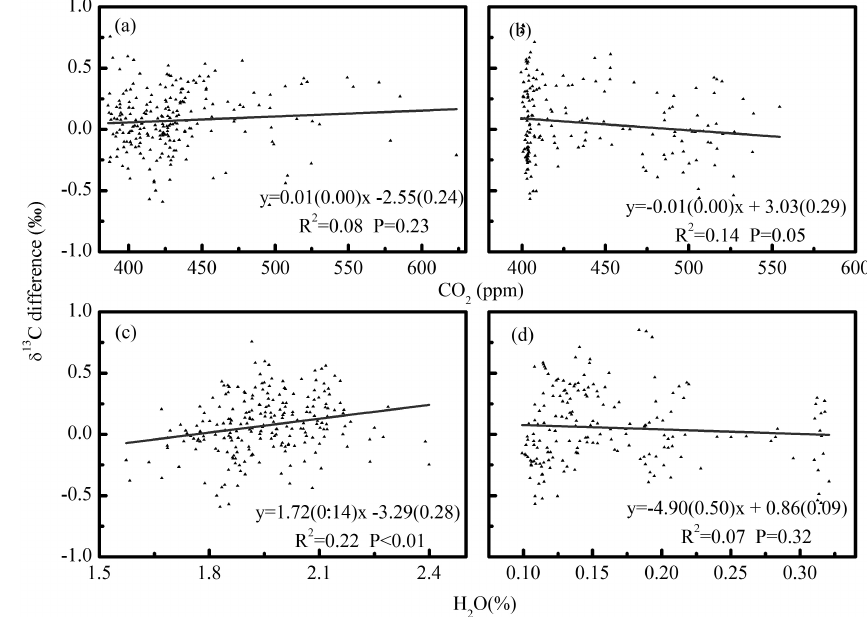
Figure 8. Dependence of the atmospheric δ 13C difference between the Picarro G1101-i and G2201-i analyzers on the CO2 and H 2 O concentration. Panels (a) and (c) show dependence measured before G1101-i was upgraded (G1101-i-original) (DOY 164–174), and (b) and (d) show dependence measured after G1101-i was upgraded (G1101-i-upgraded) (DOY 348–356).